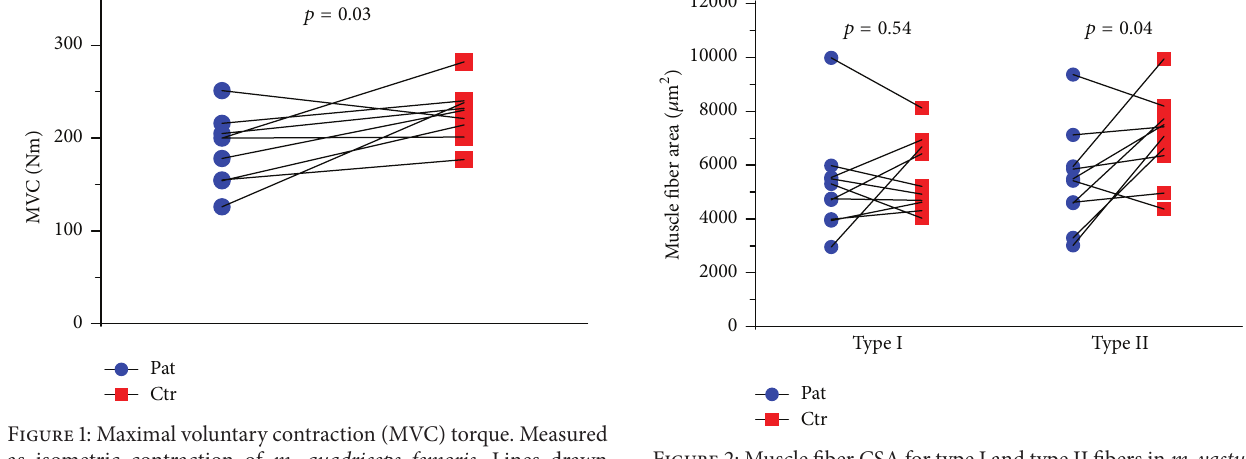
Figure 2: Muscle fiber CSA for type I and type II fibers in m. vastus lateralis . Lines drawn signify the pairwise match of